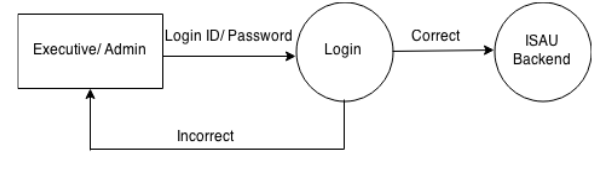
Figure 16. Level 1 DFD for Executive within ISAU